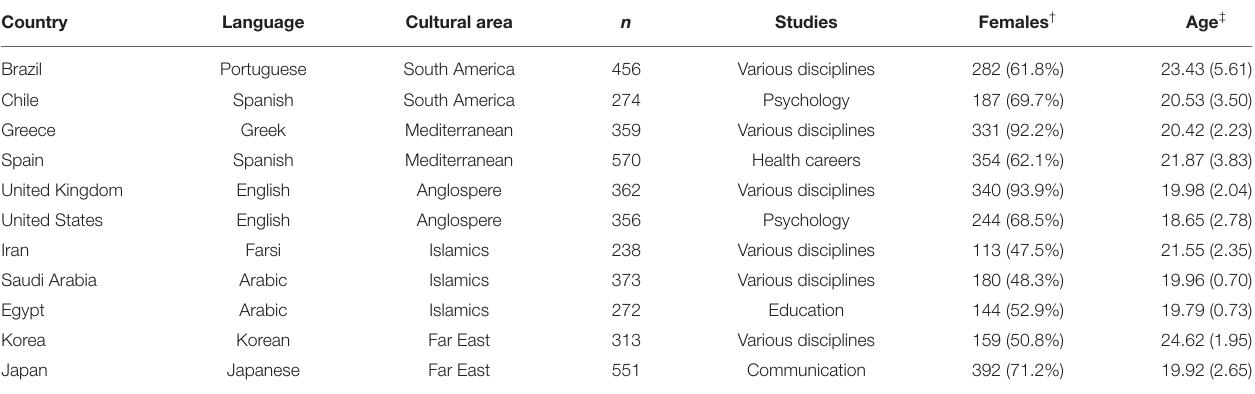
TABLE 1 | Characteristics of the study